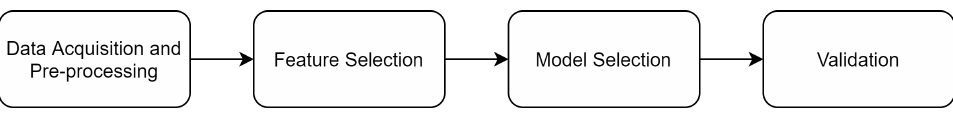
Figure 1. Machine Learning